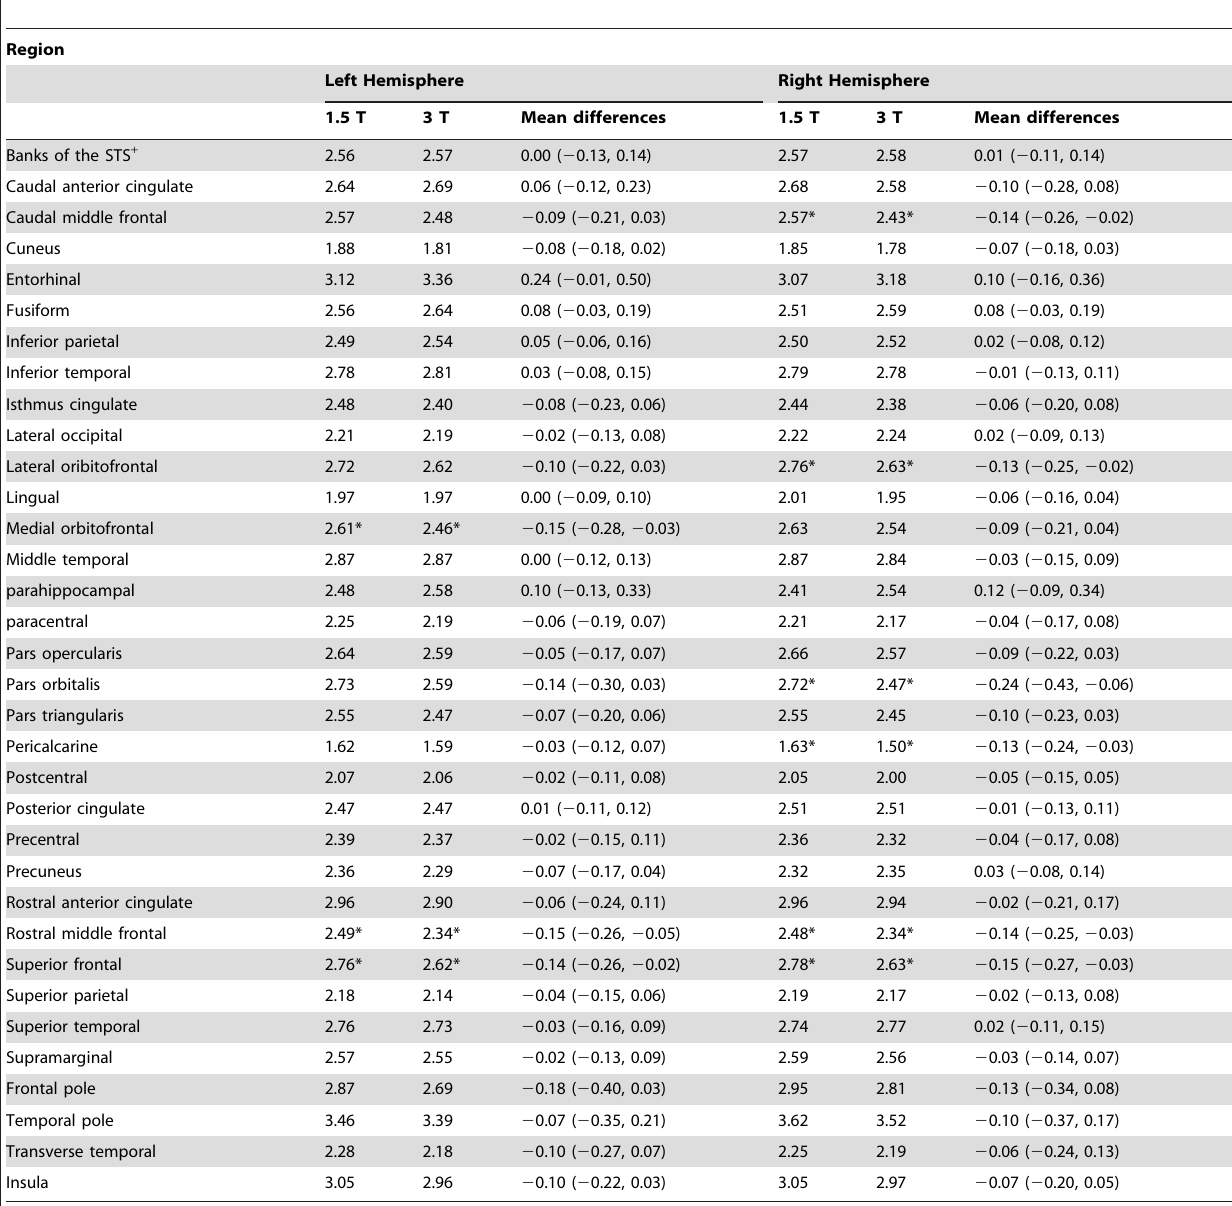
Table 9. Adjusted means and mean differences (95% confidence interval) of regional cortical thickness between 1.5 T and 3 T for males in the age group 41–55 after controlling for confounding